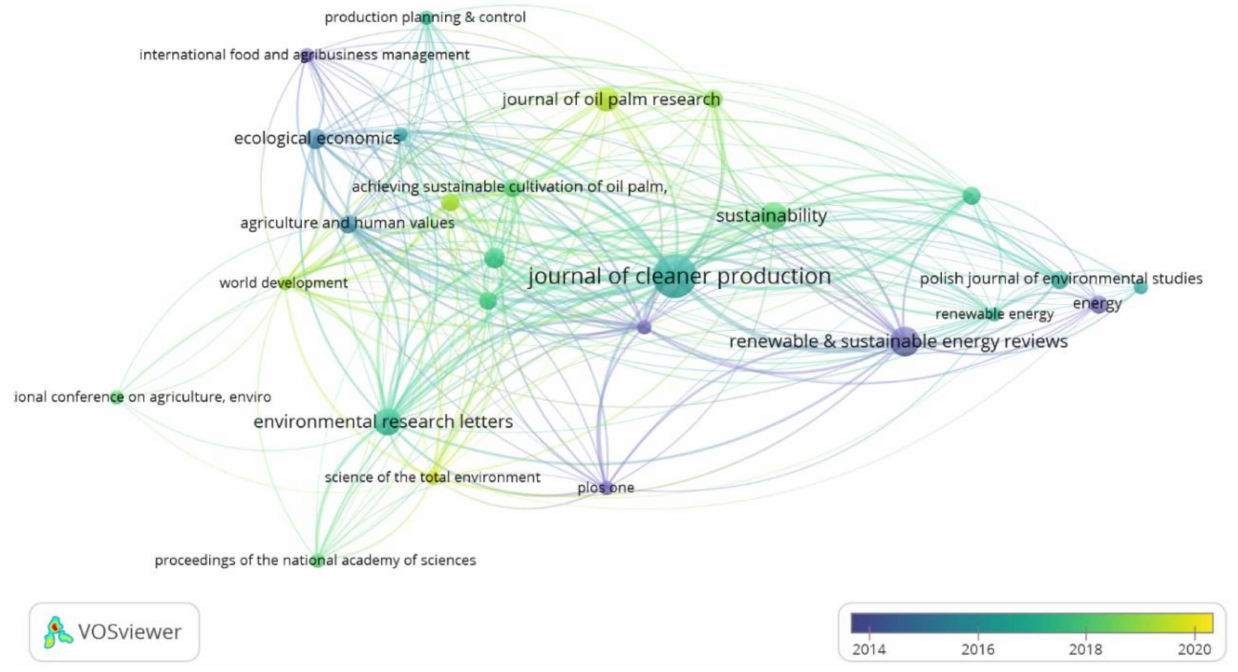
Figure 7. Bibliometric coupling (publication sources).